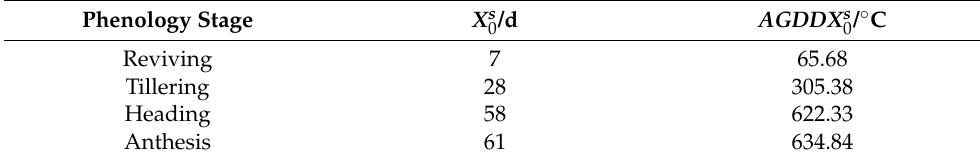
of different shape models for early rice. and X s 0 0